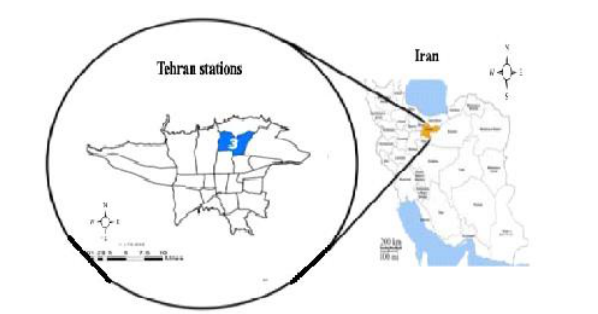
Fig. 1: Location of the study area with respect to 22 Districts of Tehran